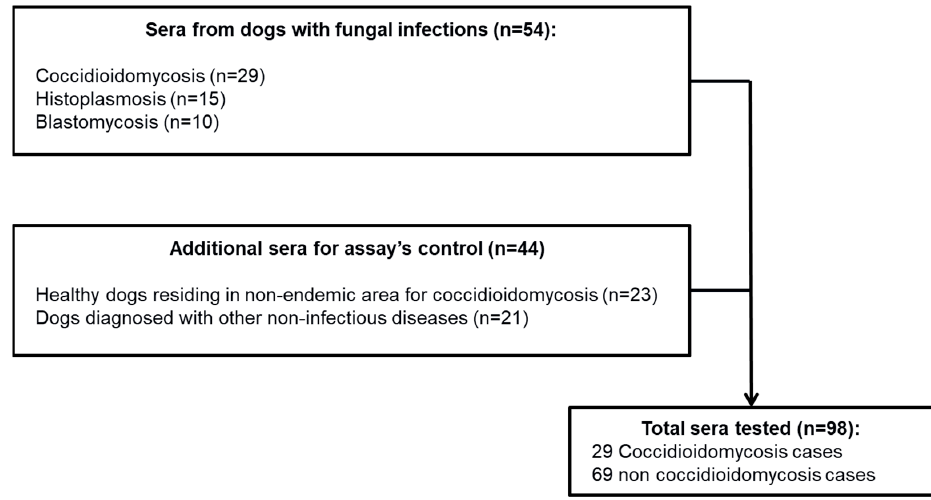
Figure 1. Flow chart of serum samples tested for the validation of the immunodiagnostic assays for the rapid diagnosis of coccidioidomycosis in dogs.